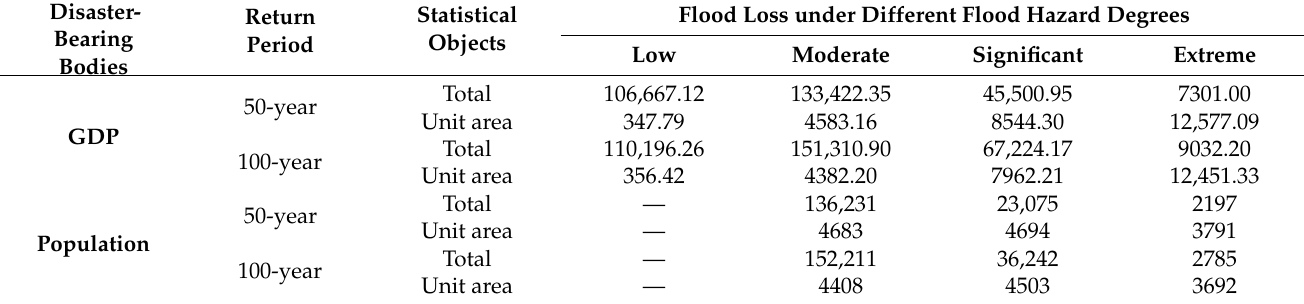
Table 8. The total disaster loss and disaster loss per unit area under different flood hazard